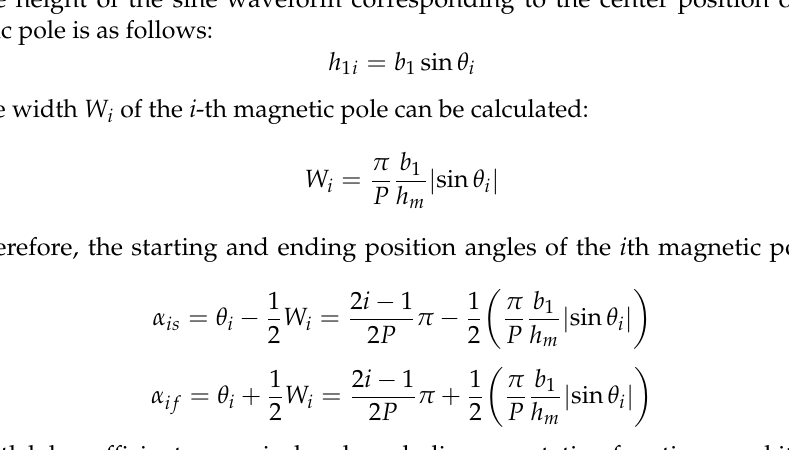
Table 1. Actual parameters of PM